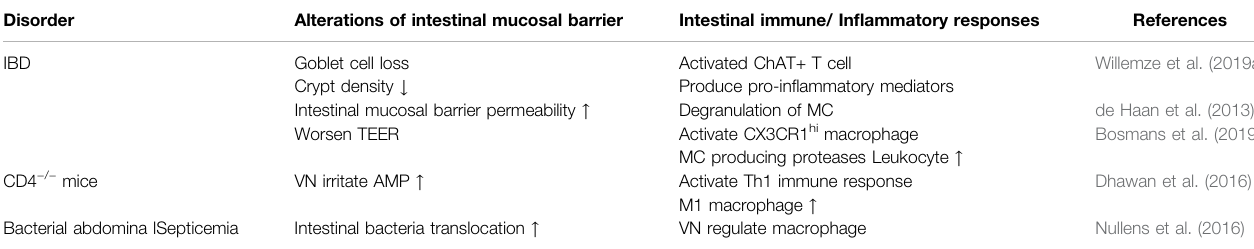
TABLE 2 | Summary of VN-intestinal immune manifestations in different diseases.